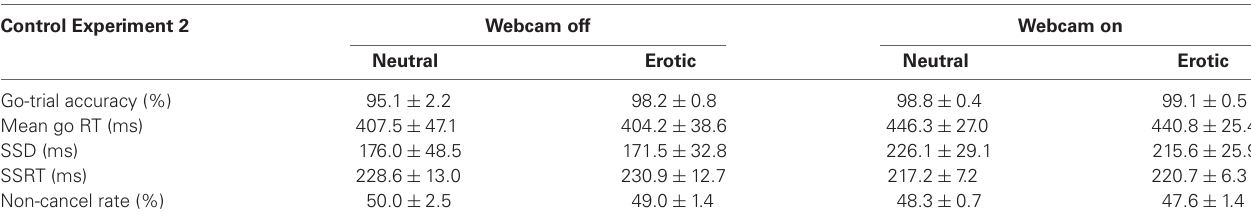
Table 3 | Summary of the Control Experiment 2 results (mean ± standard